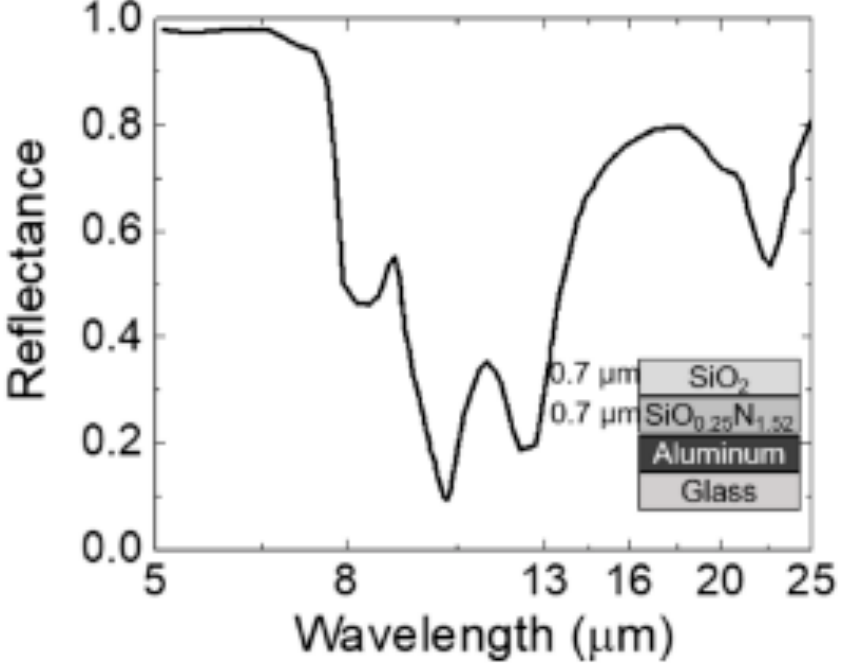
Figure 10. Polyethylene (PE) thin film with amorphous SiC nanoparticles [71].